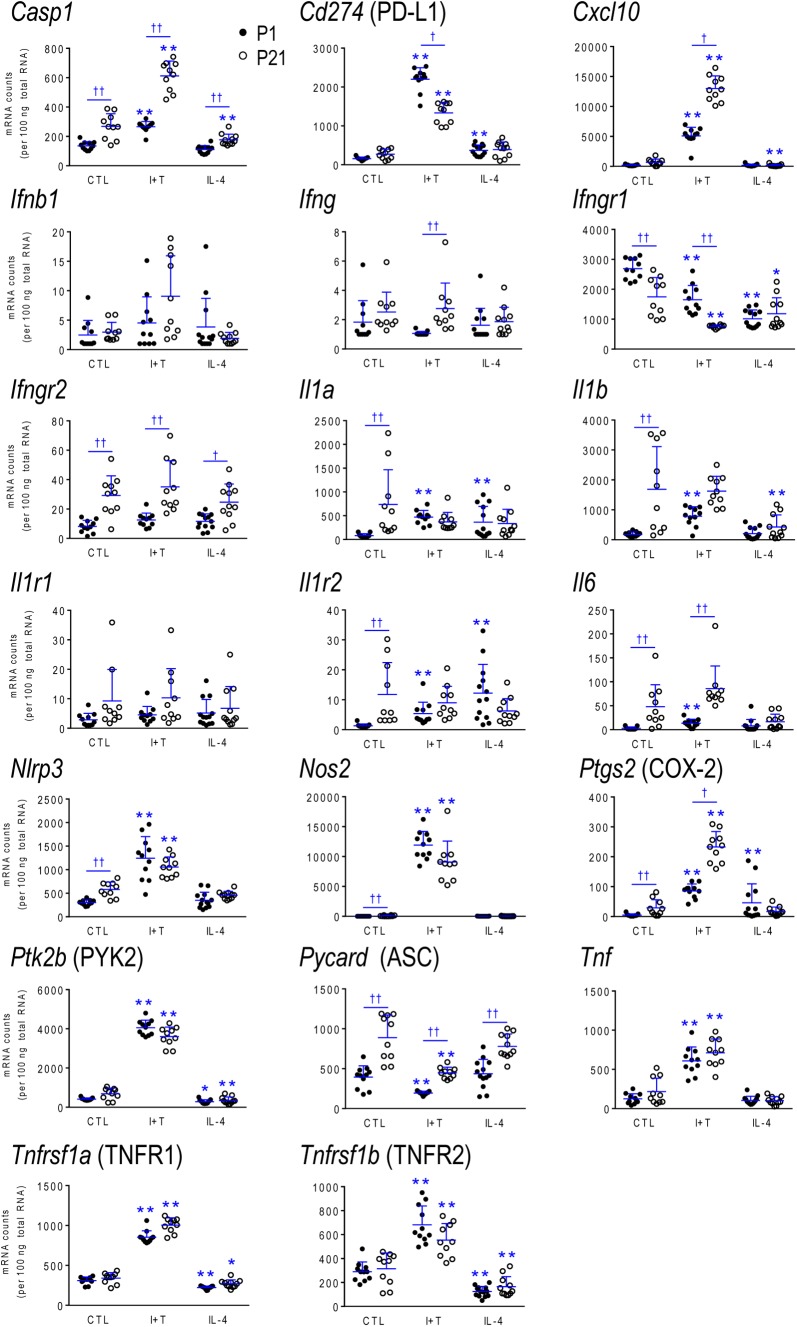
Age-dependent transcriptional responses: Pro-inflammatory mediators. Rat microglia were unstimulated (CTL) or stimulated for 24 h with IFNγ and TNFα (I+T) or IL-4. Transcript expression of each gene is shown as mRNA counts normalized to two housekeeping genes (see Materials and Methods). For clarity, protein names are included for some genes. The scatterplots show individual values and the mean ± SD. Differences shown are with respect to control microglia (∗) and between P1 and P21 cells (†). One symbol of either type indicates p < 0.05; two symbols, p < 0.01.